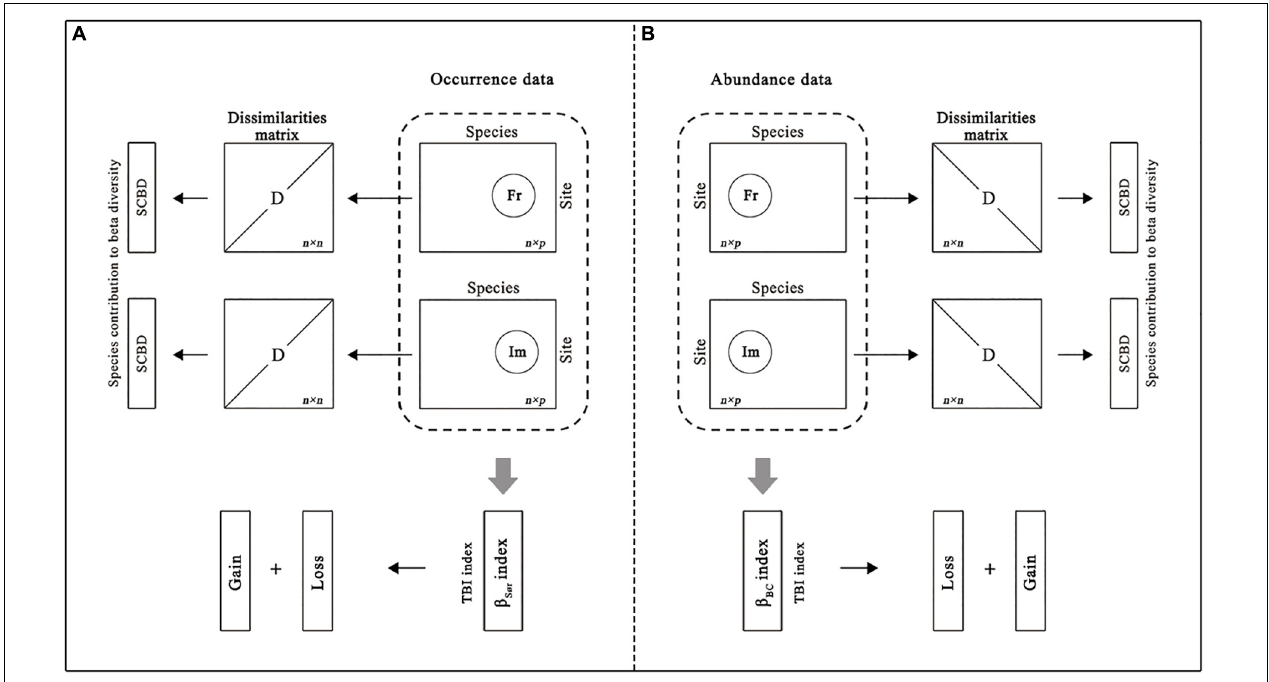
FIGURE 2 | Schematic diagram of the comparison of community data ( n site × p species) for two different habitat types, impoundments ( Im ) and free-flowing segments ( Fr ). We calculated the temporal beta diversity (TBI) using the Sørensen dissimilarity index ( β Sør ) for (A) occurrence data and the Bray-Curtis dissimilarity index ( β BC ) for (B) abundance data. The TBI was further partitioned into gain and loss components, based on the method of Legendre (2019). In addition, we first obtained the dissimilarity matrix ( n × n site) for each habitat type, and then we calculated the species contribution to beta diversity (SCBD) of individual species for each habitat type separately (adapted from Kuczynski et al.,